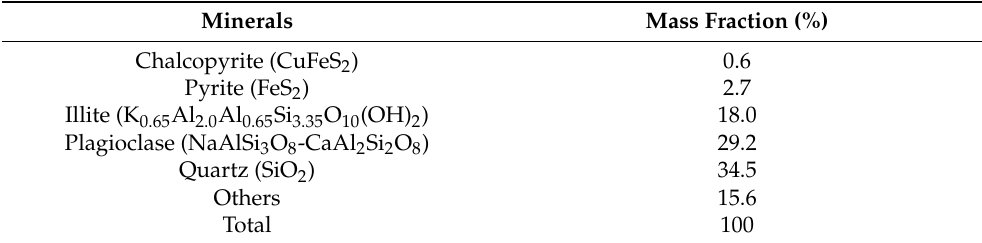
Table 1. Mass fractions of dominant ore minerals and gangues (wt.%).